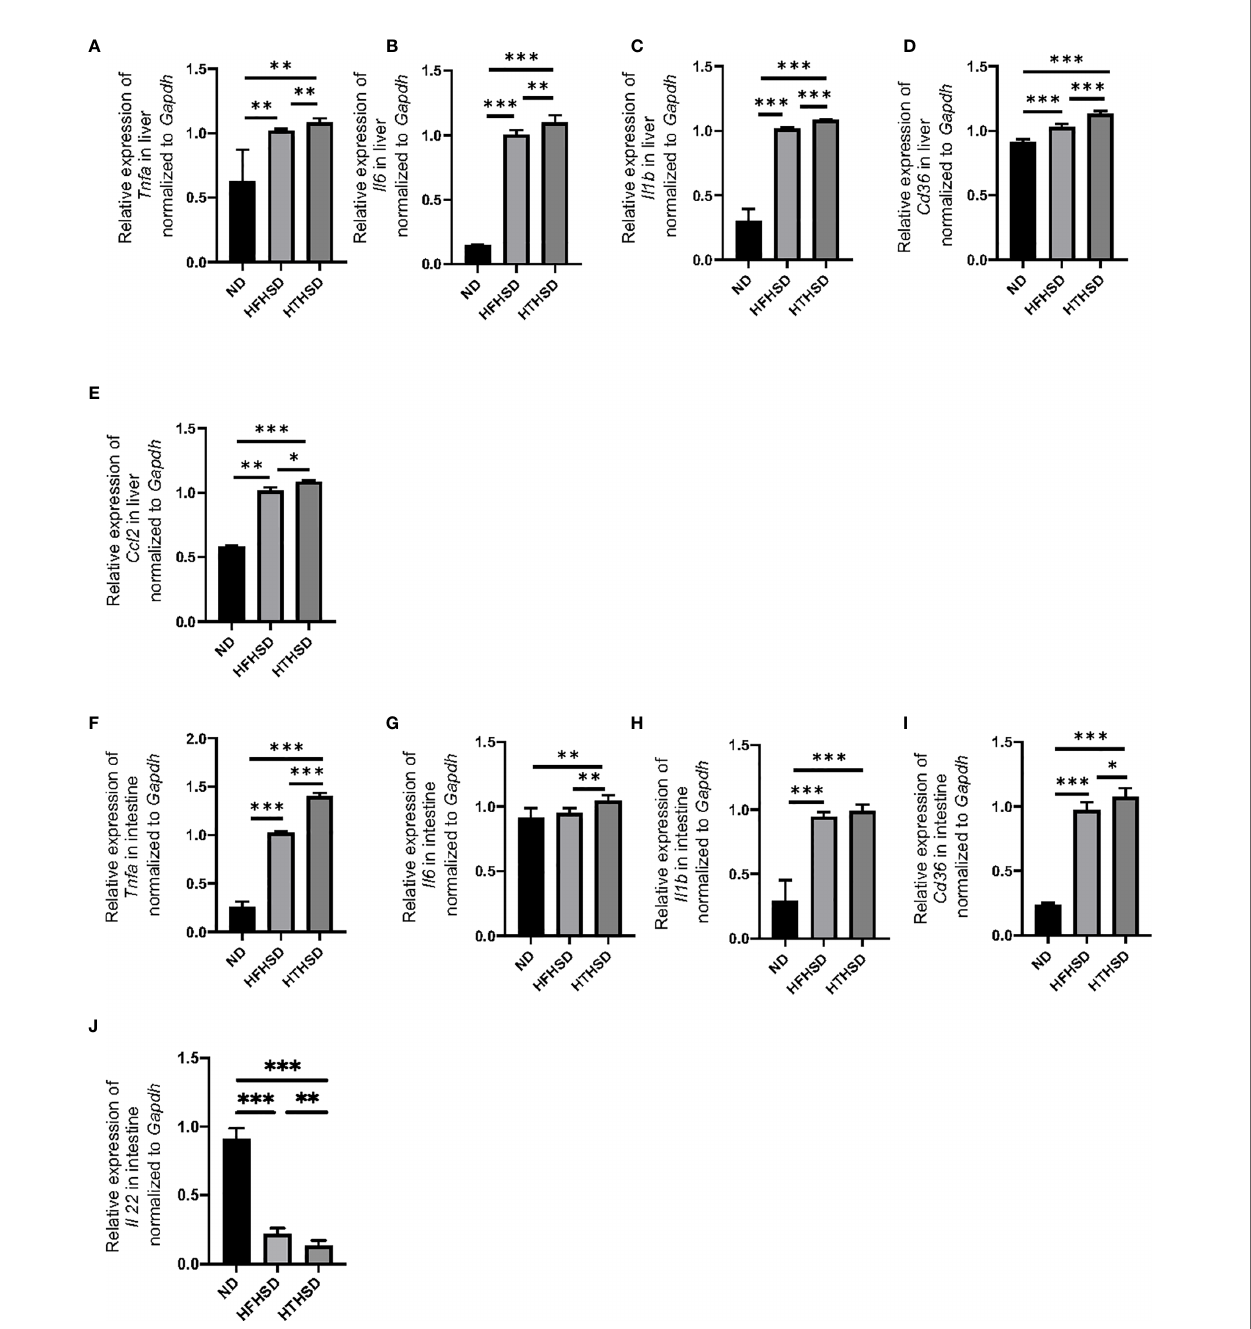
FIGURE 2 | Mice fed with HTHSD displayed signi fi cantly elevated in fl ammation-related gene expression, than mice fed with HTHSD. Gene expression (n=6) in the liver for: (A) Tnfa , (B) Il6 , (C) Il1b , (D) Cd36 , and (E) Ccl2 . Gene expression (n=6) in the small intestine for: (F) Tnfa , (G) Il6 , (H) Il1b , (I) Cd36 , and (J) Il22 . Data are represented as mean±SD; *p < 0.05, **p < 0.01, ***p < 0.001 using one-way ANOVA and an unpaired, two-tailed Student ’ s t test. ND, normal diet; HFHSD, high- fat, high-sucrose diet; HTHSD, high-trans fatty acid, high-sucrose